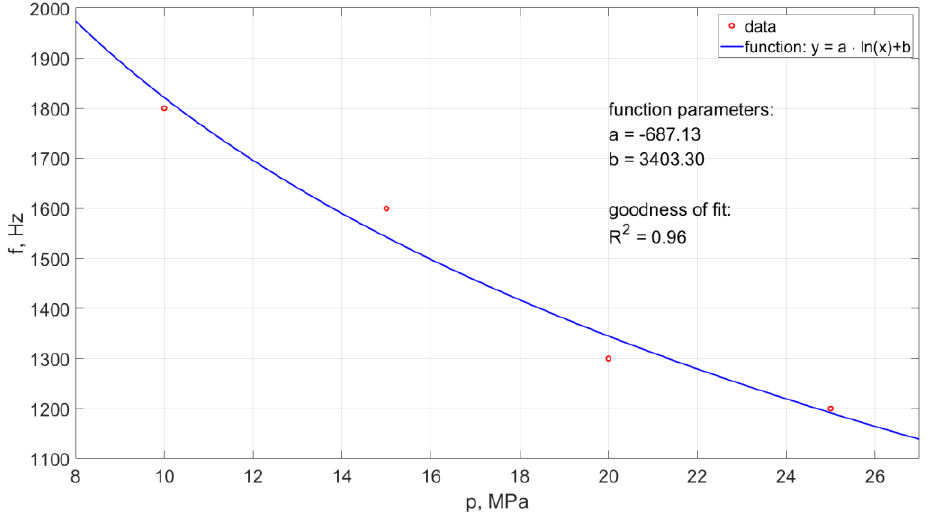
Figure 19. Influence of the change of nominal water pressure on the frequency of recorded hy- drodynamic impulses, produced in a self-excited pulsed head designed for drilling holes, working in the water environment.